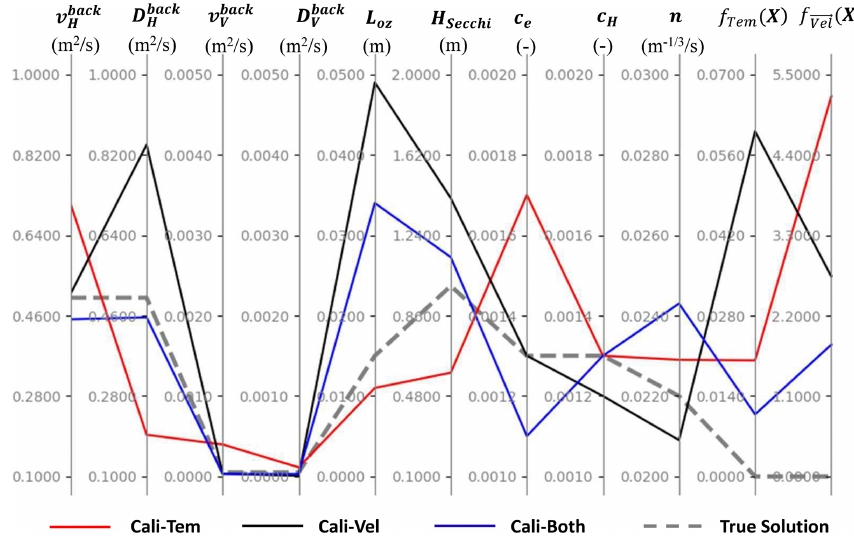
Figure 5. Parallel axis plot for the parameter value and the composite error of temperature and velocity of calibration solutions under different scenarios (Cali-Tem, Cali-Vel, and Cali-Both). True solution defined in Table 2 is given for reference. Smaller variable errors ( f Tem ( X ) , see Eq. 5 and f Vel ( X ) , see Eq. 8) are better, and the variable errors of the true solution ( X R ) are zero (for both f Tem ( X ) and f Vel ( X )) . The parameter symbols are defined in Table